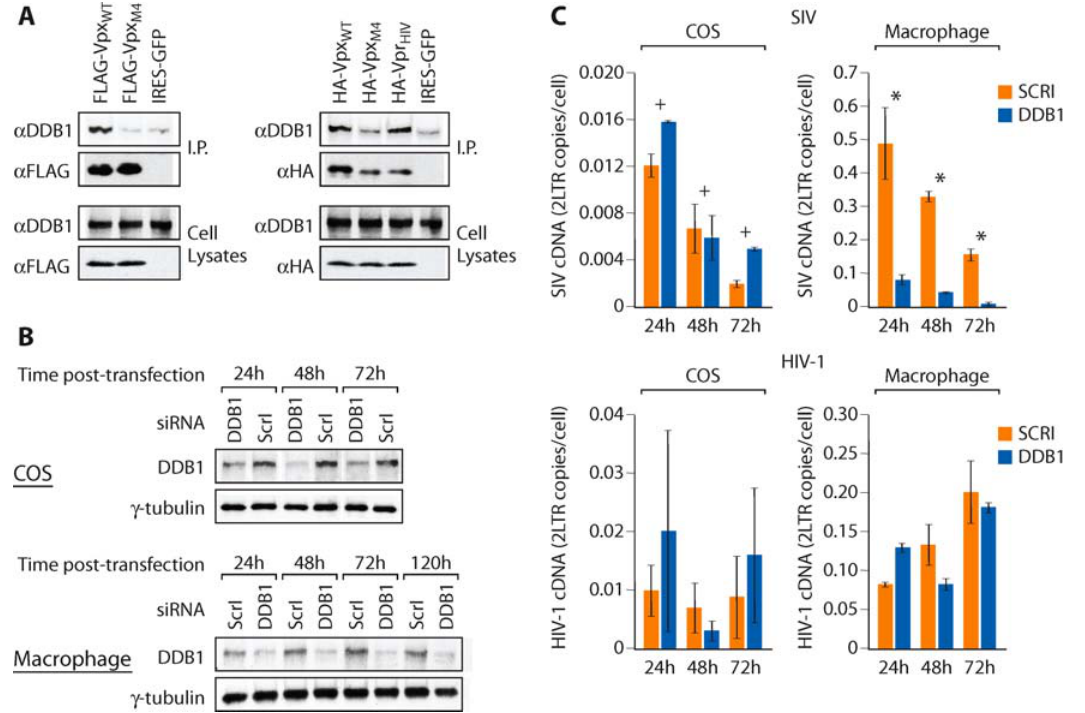
Figure 7. Inactivation of the macrophage restriction to SIV by Vpx requires DDB1. (A) Association of SIV Vpx with endogenous DDB1. Association of DDB1 with wild-type Vpx (Vpx WT ) and non-ubiquitylated Vpx (Vpx M4 ) was evaluated in 293T cells expressing FLAG-tagged Vpx (left panels) or HA-tagged Vpx (right panels) or IRES-GFP as a control. FLAG and HA immunoprecipitates were immunoblotted with DDB1 or FLAG and HA antibodies (upper panels). Levels of endogenous DDB1 and expressed Vpx in cell lysates were confirmed by Western blotting with a DDB1 antibody and with FLAG/HA antibodies respectively (lower panels). (B) Efficiency of siRNA-mediated silencing of DDB1 expression in COS cells and in macrophages was evaluated by Western blotting with DDB1 antibody at the indicated intervals post siRNA-transfection (Scr I -scrambled siRNA control). (C) Impact of DDB1 silencing on SIV and HIV-1 infection of COS cells and macrophages. SIV and HIV-1 infection was gauged from the quantity of viral cDNA (2-LTR) at 24, 48 and 72 h post infection ( + , p . 0.05; *, p , 0.005) (error bars are s.d. of replicate PCRs of a single DNA sample).